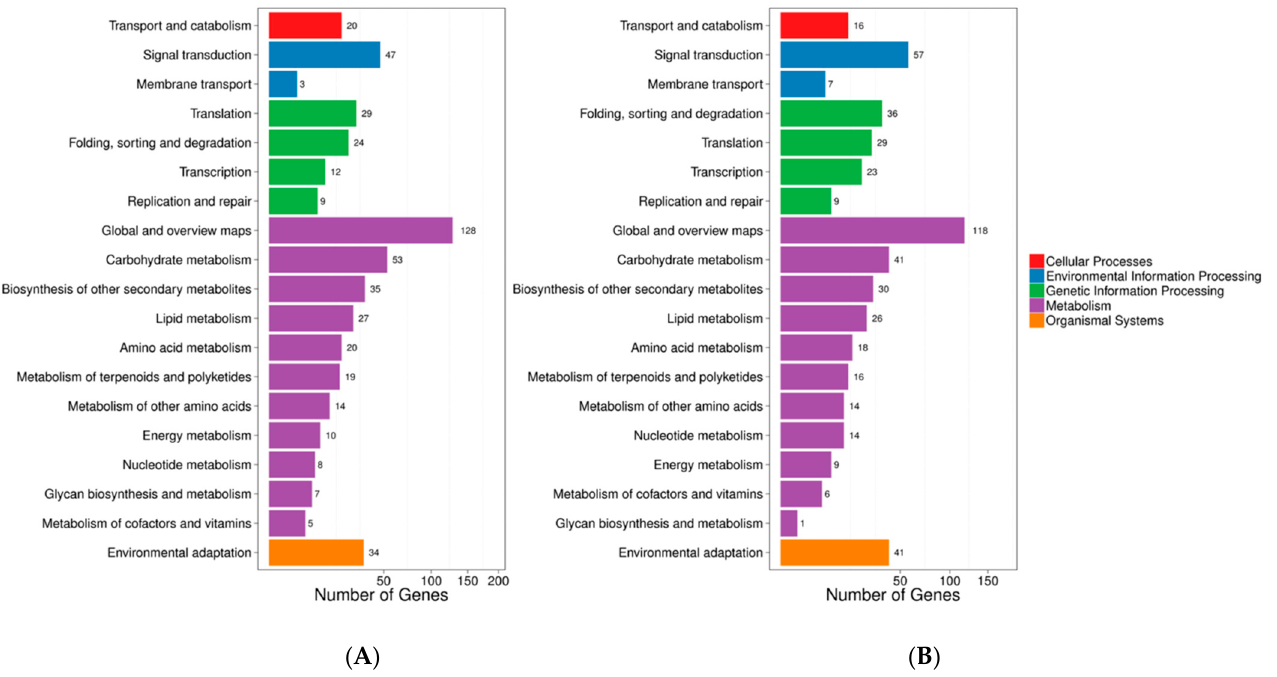
Figure 6. Venn diagram of transcripts in pomegranate pericarp. Control, RTS3 and RTS6 represent the pericarp of fruit stored for 0, 3 and 6 d.